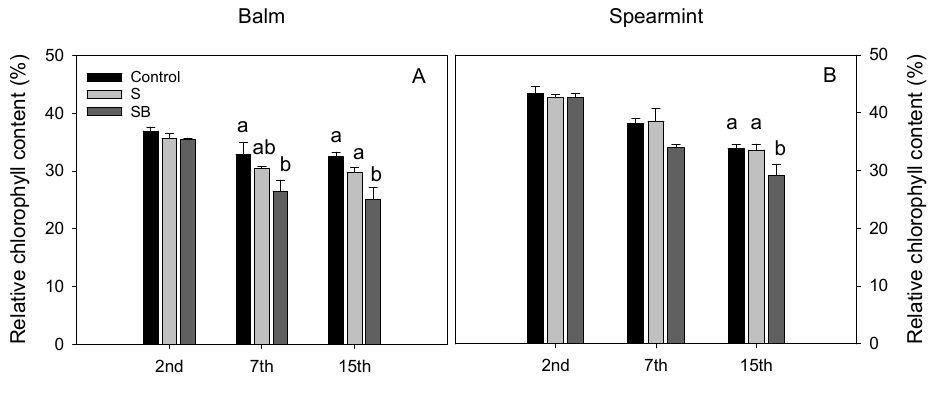
Figure 1. Relative chlorophyll content in balm ( A ) and spearmint ( B ) plants irrigated with water from different sources. Bars without lowercase letters mean no significant differences between treatments. Different lowercase letters indicate significant differences between treatments according to Duncan’s test at p ≤ 0.05 .